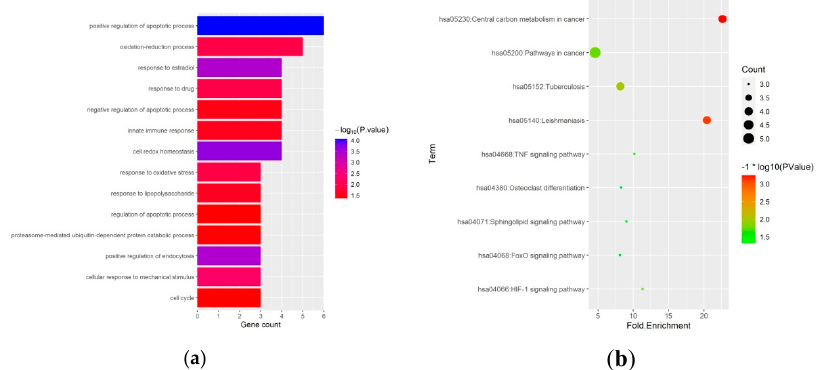
Figure 2. The expression levels of 27 ferroptosis-related differentially expressed genes in GIONFH and non-GIONFH samples.